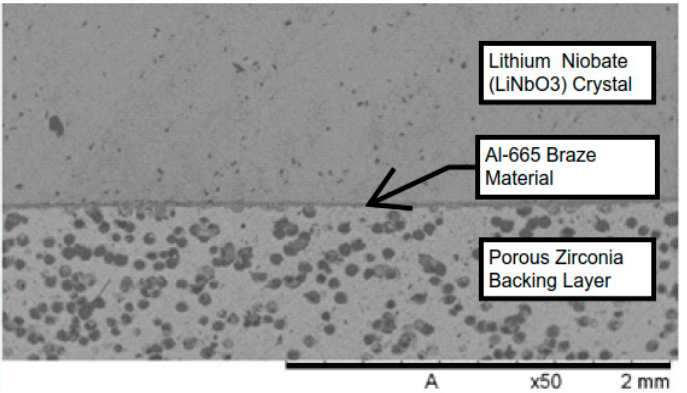
Figure 6. SEM sectioned view of a joint between LiNbO 3 and porous zirconia, brazed with Al-665 material.